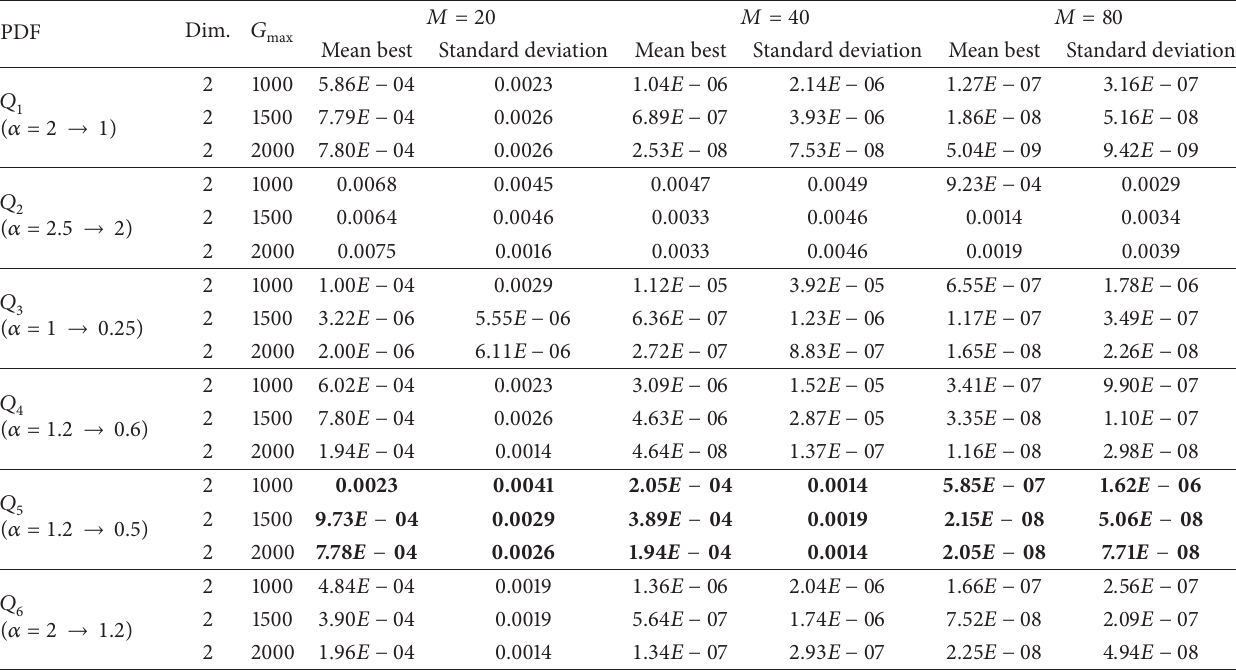
Table 6: Mean best fitness values and standard deviation for the Schaffer